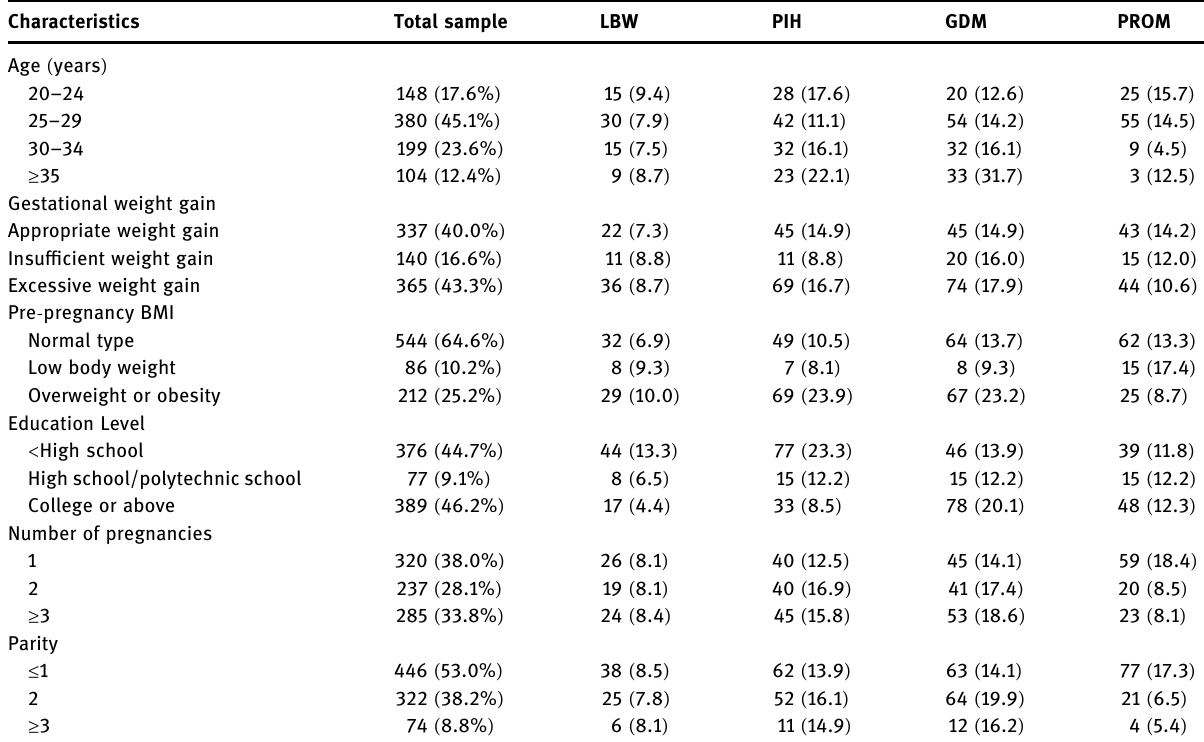
Table 1: The characteristics at baseline of birth outcomes n ( %